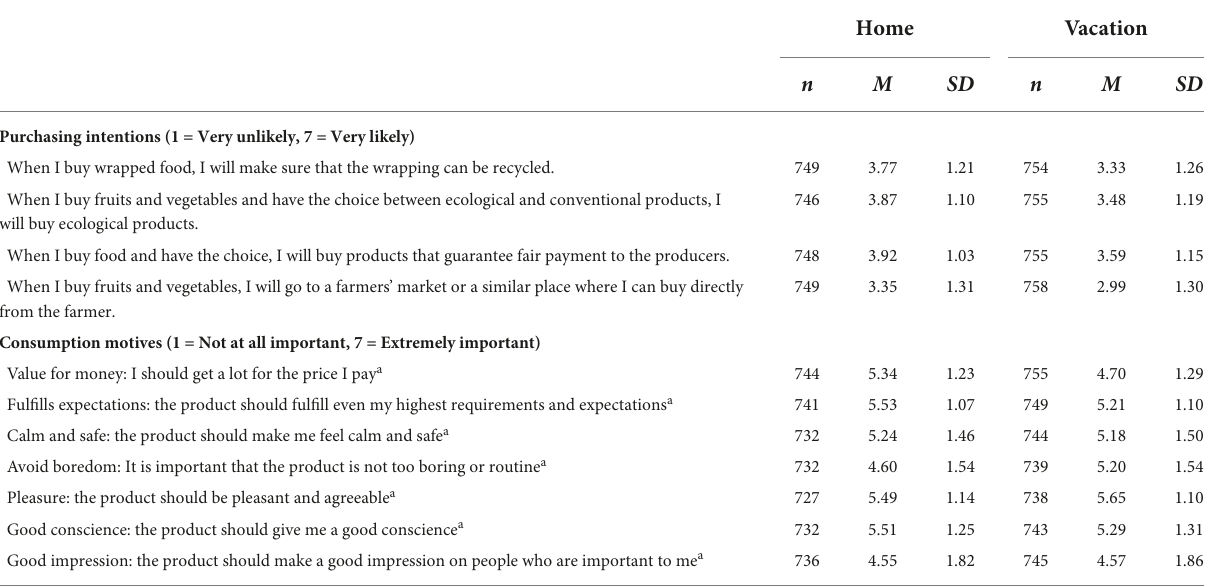
TABLE 2 Means and standard deviations for item